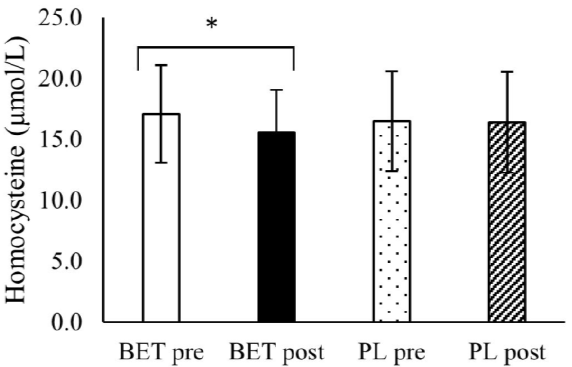
Figure 2. The effect of betaine supplementation on homocysteine concentration. BET post , after betaine supplementation; BET pre , before betaine supplementation; PL post , after placebo supplementation; PL pre , before placebo supplementation, * BET pre vs BET post p value= 0.020.